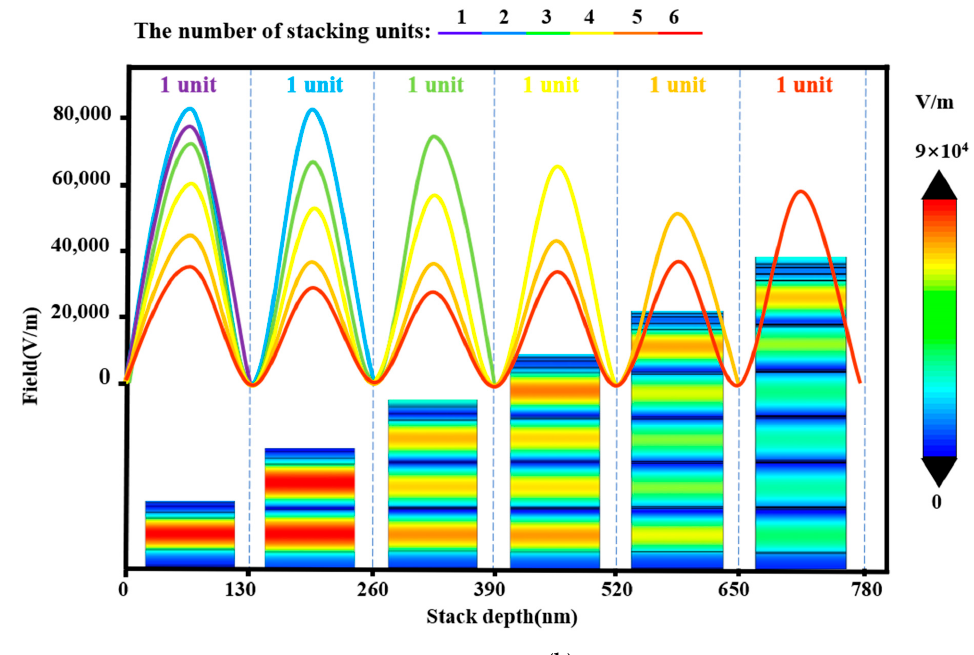
Figure 6. ( a ) Simulated the reflection spectra under different stacking unit numbers. ( b ) The electric field intensity of the structure varies with the stacking depth under different stacking units. The contour map of electric field intensity is under the curve.